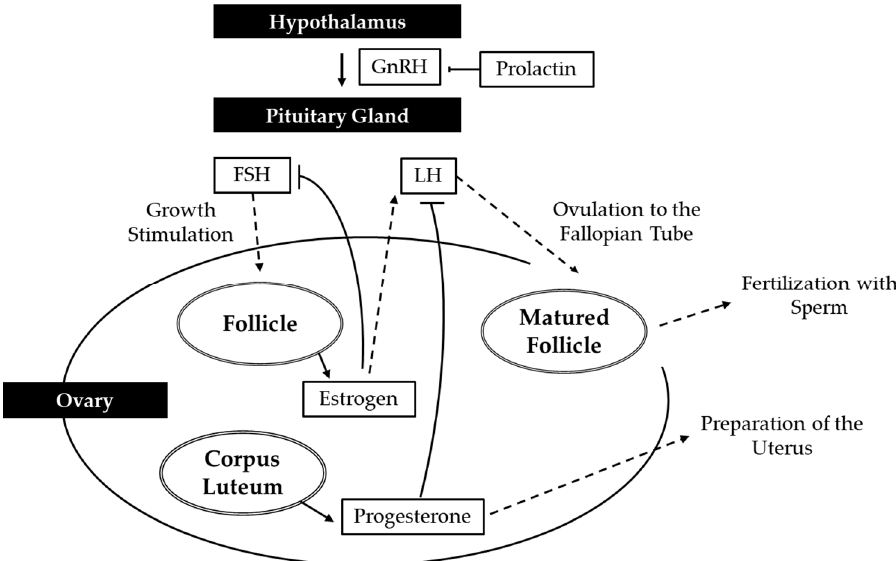
Figure 2. Female sex hormone formation. GnRH secreted from the hypothalamus induces the production of FSH from the pituitary gland to stimulate follicle growth. Estrogen induces the production of LH which ovulates the mature follicle, while progesterone made from the corpus luteum inhibits the activation of LH.